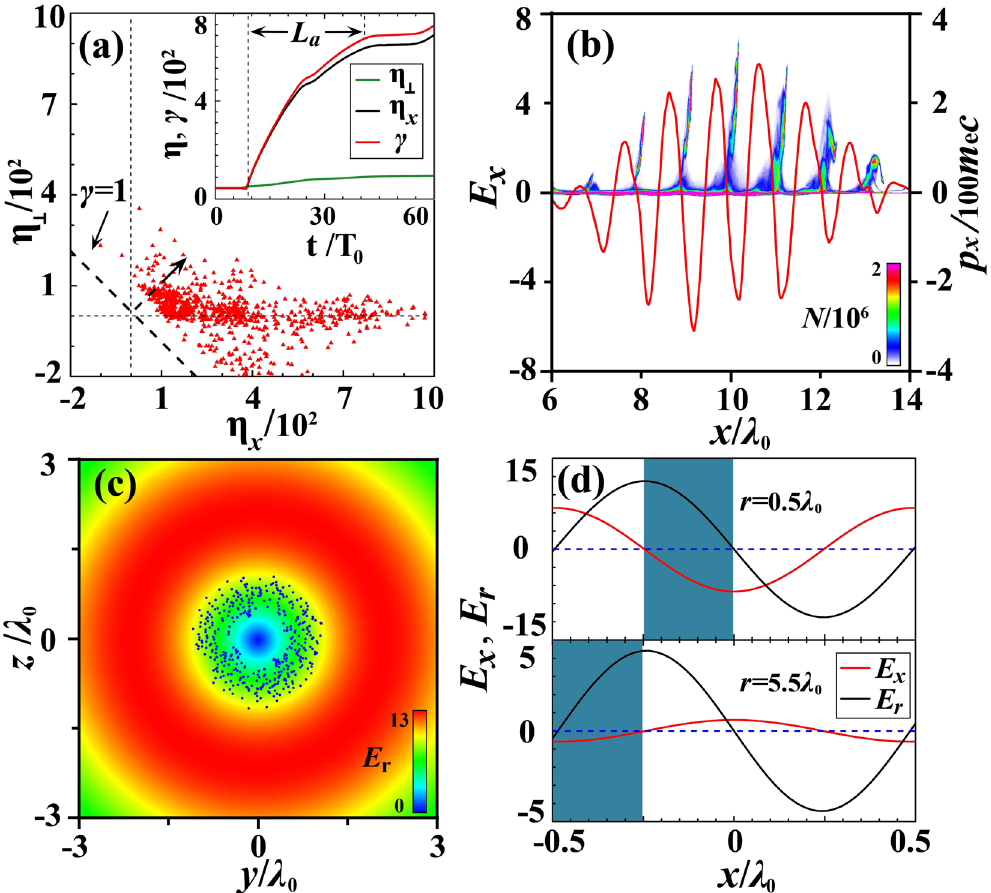
Figure 2. The tracked electrons in ( η x , η ⊥ ) ( a ) and ( x , p x ) space ( b ) at t = 16 T 0 . The red curve shows the axial electric field E x in ( b ). The radial electric field E r experienced by an electron bunch marked in Fig. 1 at t = 16 T 0 , with blue dots representing the positions of the bunch electrons ( c ). Phase-locking of electrons in a single laser period with r = 0.5 λ 0 (top) and 5.5 λ 0 (bottom) ( d ). Here, the shadow marks the phase-locking zone. The electric field is normalized by E 0 = m e c ω 0 / q e